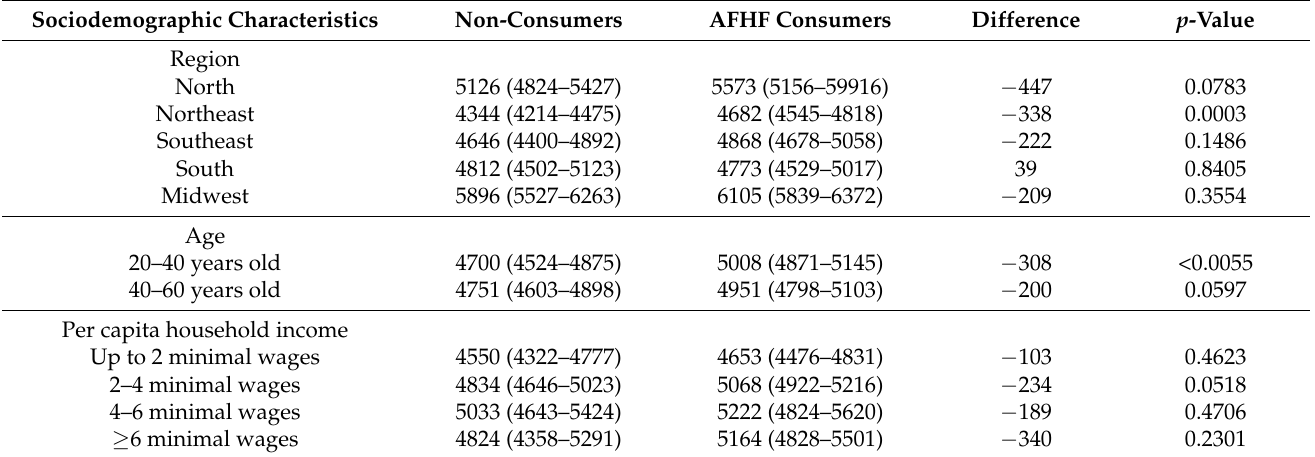
Table 2. Mean energy-adjusted carbon footprint (gCO 2 e/person/day) according to the consumption of away-from-home food (AFHF) and sociodemographic characteristics. Brazilian adults in urban areas, 2017–2018 (n =